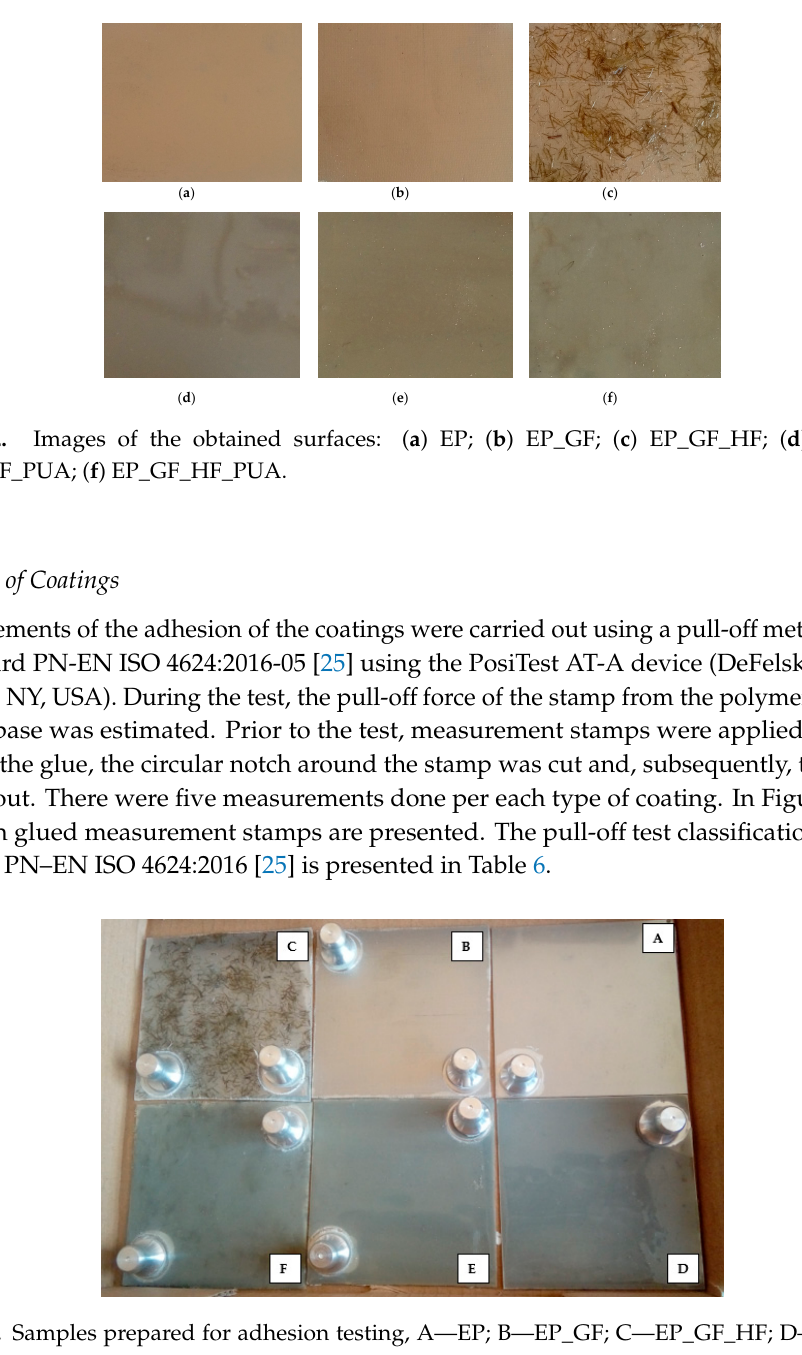
Table 7. Results of the adhesion pull-off tests.